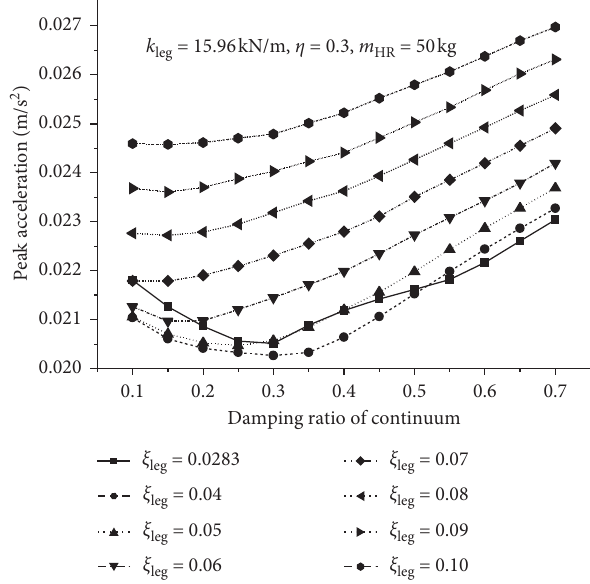
Figure 16: Peak acceleration under leg stiffness 15.96kN/m, η � 0 . 3, m